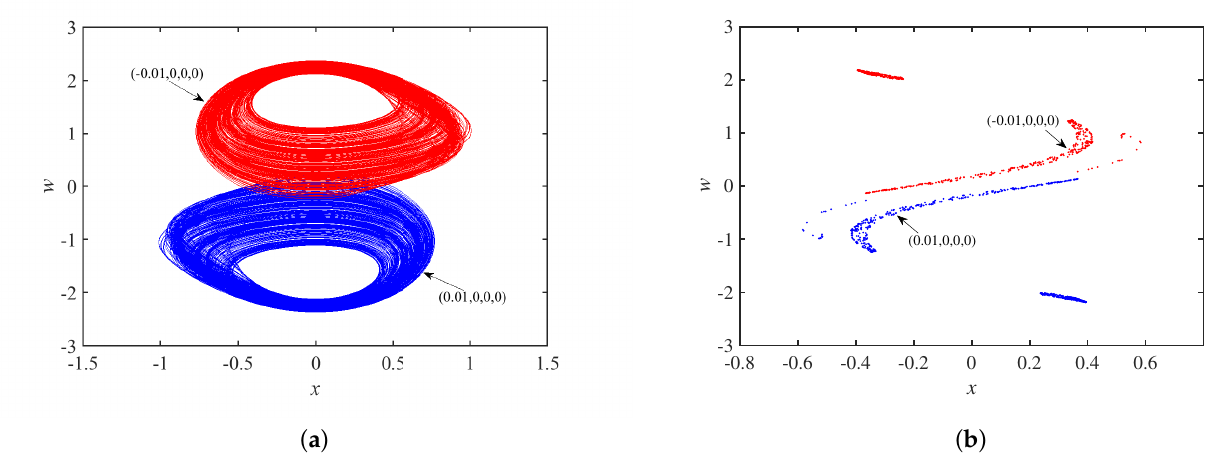
Figure 13. When a = 29, b = 0.15, c = − 0.2: ( a ) coexisting single-scroll attractors; ( b ) Poincaré